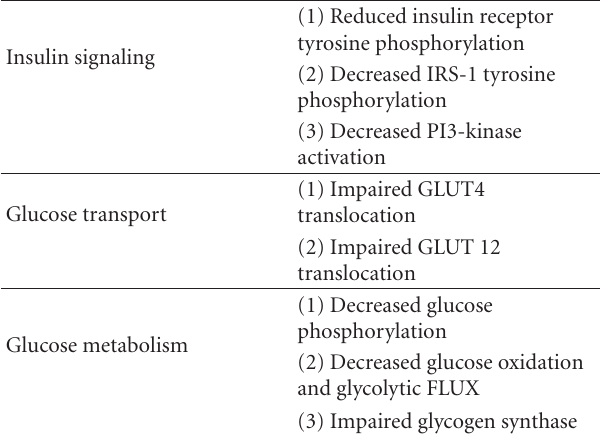
Table 1: Defects in Glucose Metabolism in Insulin Resistant Conditions.